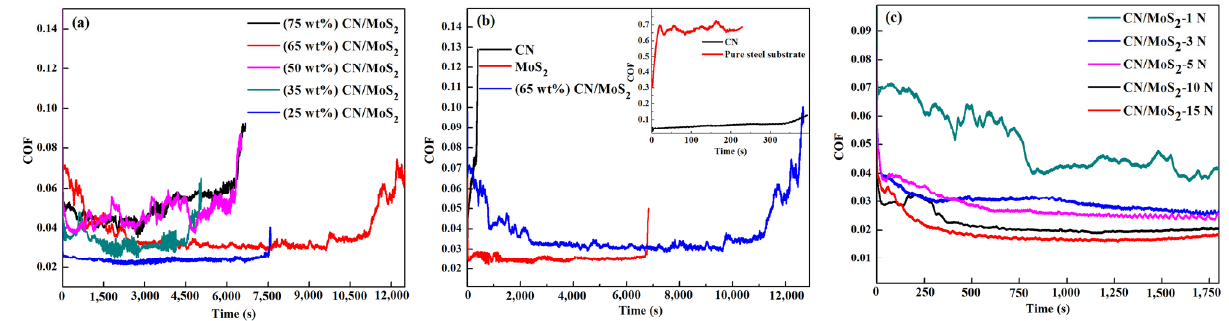
Fig. 4 (a) COF of CN/MoS 2 coating with different ratios; (b) COF of CN, MoS 2 , and CN/MoS 2 in air; (c) COF of CN/MoS 2 coating with different applied